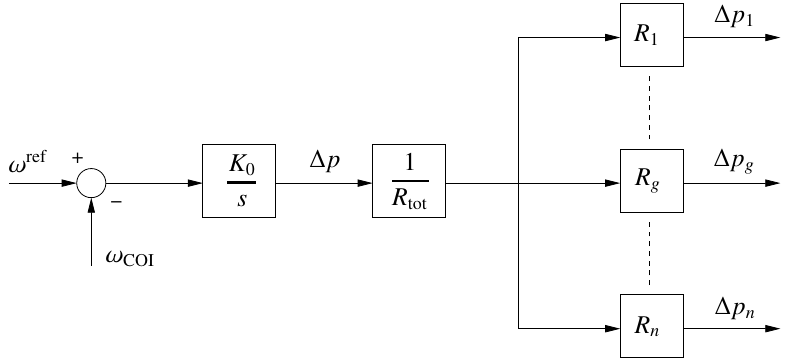
Figure 2. Simple automatic generation control (AGC) control